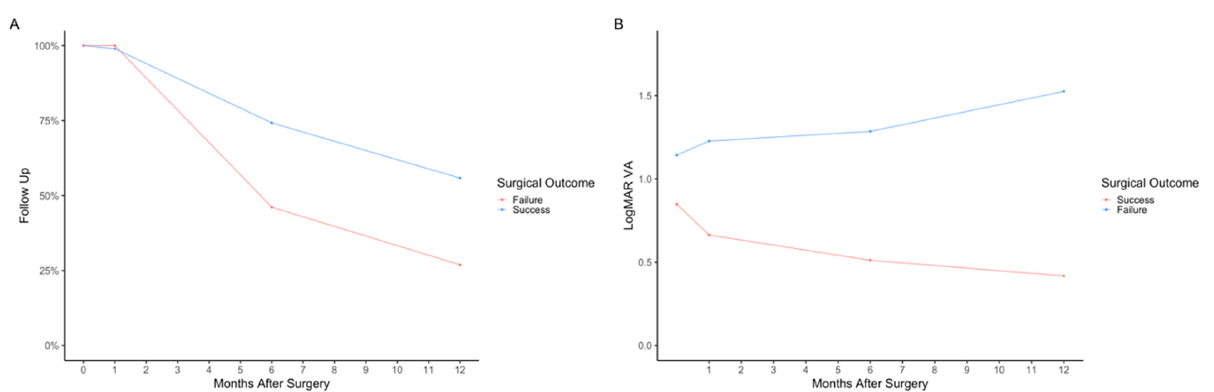
Figure 6. Comparison of successful and unsuccessful surgery outcomes by ( A ) follow-up visits attended (in percentage total) and ( B ) mean logMAR visual acuity. The four time points indicated are the preoperative visit (month 0), 1-month postoperative visit, 6-month postoperative visit, and 12-month postoperative visit.